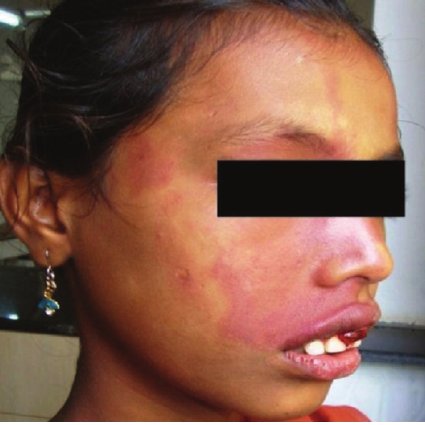
Figure 7: Extraoral view showing port-wine stain on the right side of the face.